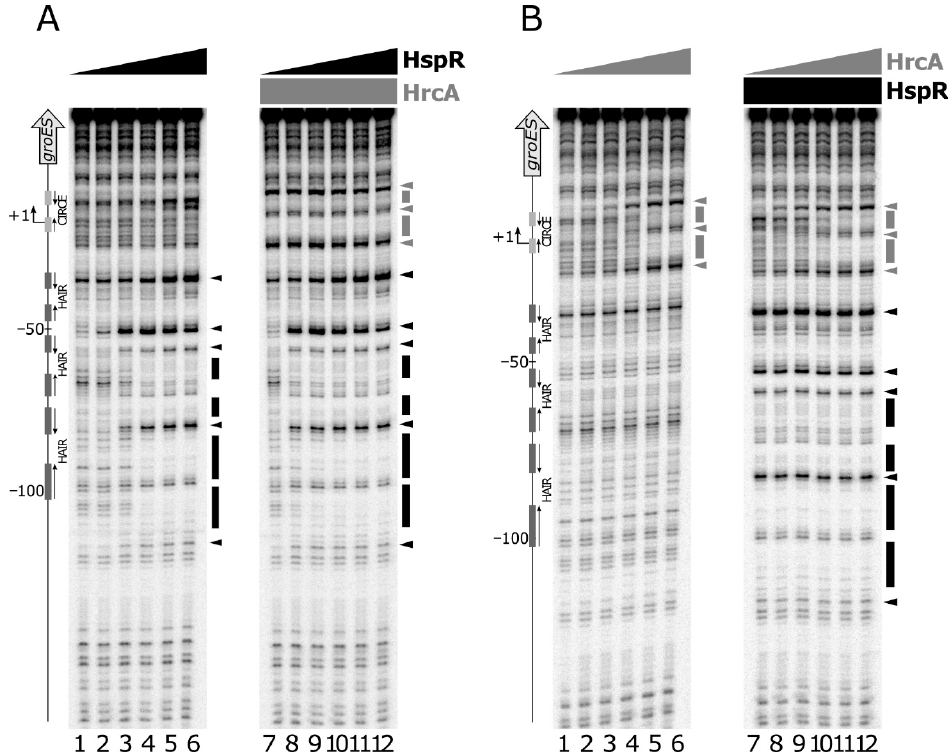
Figure 6. Panel A : DNase I footprinting analysis of HspR on the P gro promoter in the absence (left panel) and in the presence (right panel) of purified recombinant HrcA protein. A specific end ‐ labeled P gro fragment was incubated with increasing amounts of purified HspR. Lanes 1 to 6: 0, 22, 45, 90, 180 and 360 nM HspR, respectively (in each reaction 360 nM GST was added as a control protein); lanes 7 to 12: 0, 22, 45, 90, 180 and 360 nM HspR, respectively (in each reaction, 360 nM HrcA was added). Molar ratio between HspR and HrcA, lanes 8 to 12: 1:16, 1:8, 1:4, 1:2 and 1:1. Panel B : DNase I footprinting analysis of HrcA on the P gro promoter in the absence (left panel) and in the presence (right panel) of purified recombinant HspR protein. A specific end ‐ labeled P gro fragment was incu ‐ bated with increasing amounts of purified HrcA. Lanes 1 to 6: 0, 22, 45, 90, 180 and 360 nM HrcA, respectively (in each reaction 360 nM GST was added as a control protein); lanes 7 to 12: 0, 22, 45, 90, 180 and 360 nM HspR, respectively (in each reaction 360 nM HspR was added). Molar ratio between HrcA and HspR, lanes 8 to 12: 1:16, 1:8, 1:4, 1:2 and 1:1. In each panel, regions protected from DNase I digestion are indicated by black (for HspR) or grey (for HrcA) boxes and the DNase I hypersensitive sites are depicted by black (for HspR) or grey (for HrcA) arrowheads. On the left, the bent arrow indicates the transcriptional start site, the vertical open arrow depicts the open reading frame; num ‐ bers refer to the positions with respect to the transcriptional start site. The HAIR and CIRCE sequences are indicated by dark and light grey boxes, respectively.